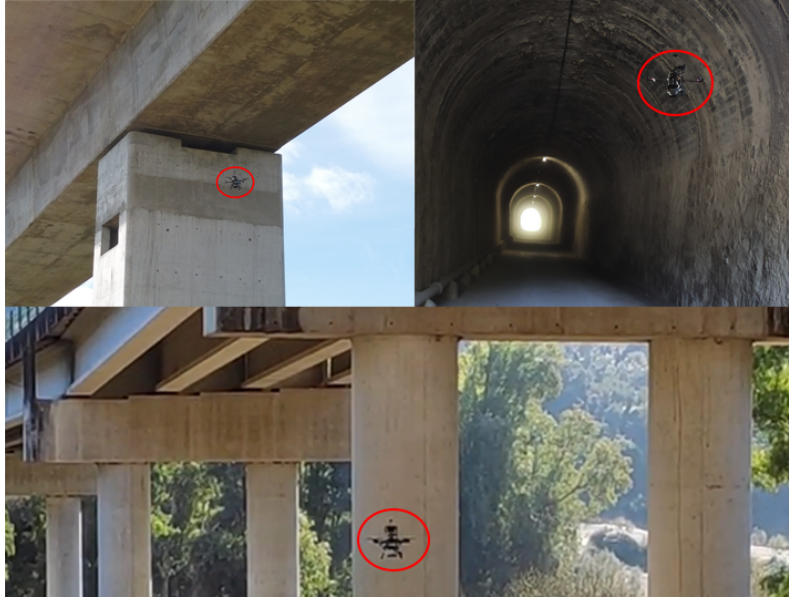
Figure 1. Example images of a UAV (circle) inspecting different civil infrastructures, such as a viaduct ( top left ), a tunnel ( top right ), and a bridge ( bottom